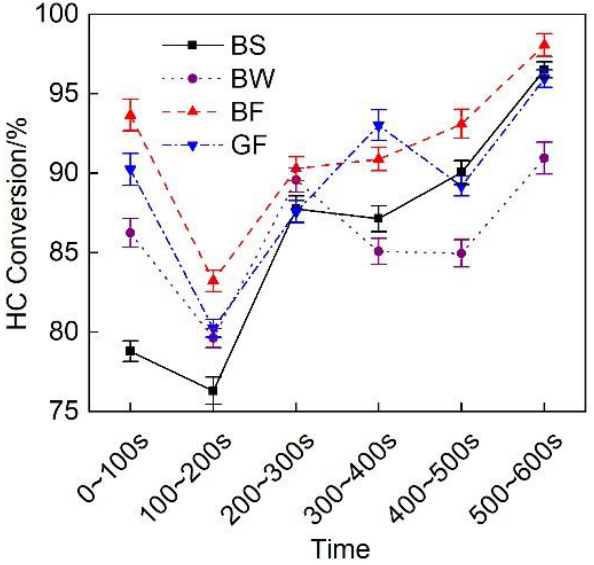
Figure 15. HC conversion efficiency of the different exhaust pipe covering schemes at each substage of the initial idling stage.